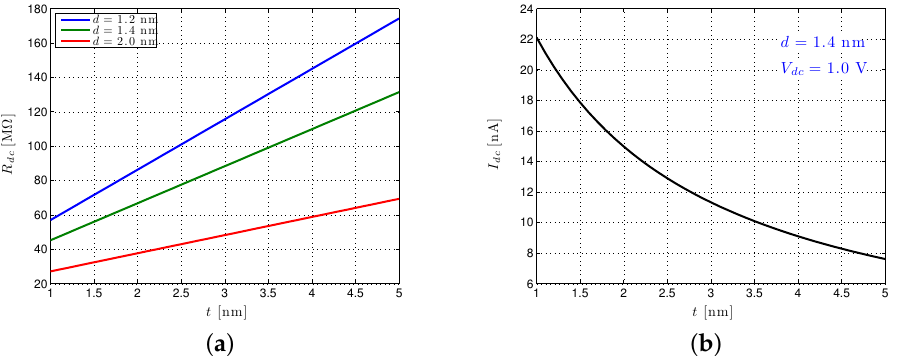
Figure 9. Key solid-state nanopore DC values ( R dc and I dc ) as a function of pore thickness ( t ). ( a ) The R dc for a range of solid-state nanopore dimensions; ( b ) the I dc for a range of solid-state nanopore thicknesses.